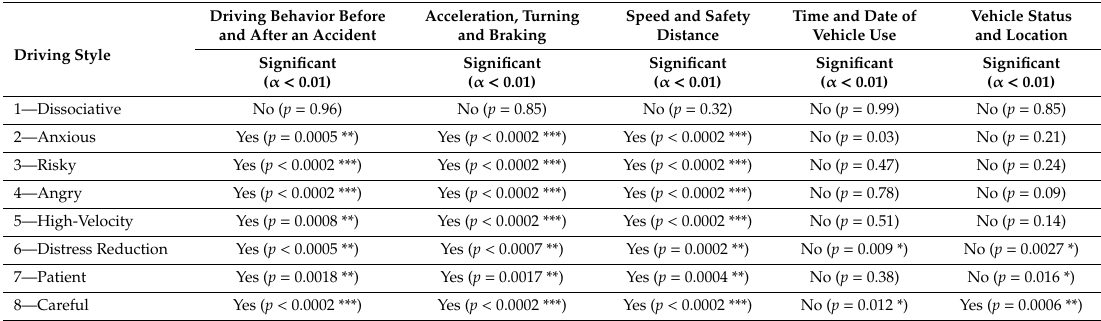
Table 11. Willingness to share by type of information and driving style quintiles (2) (*** indicates α <